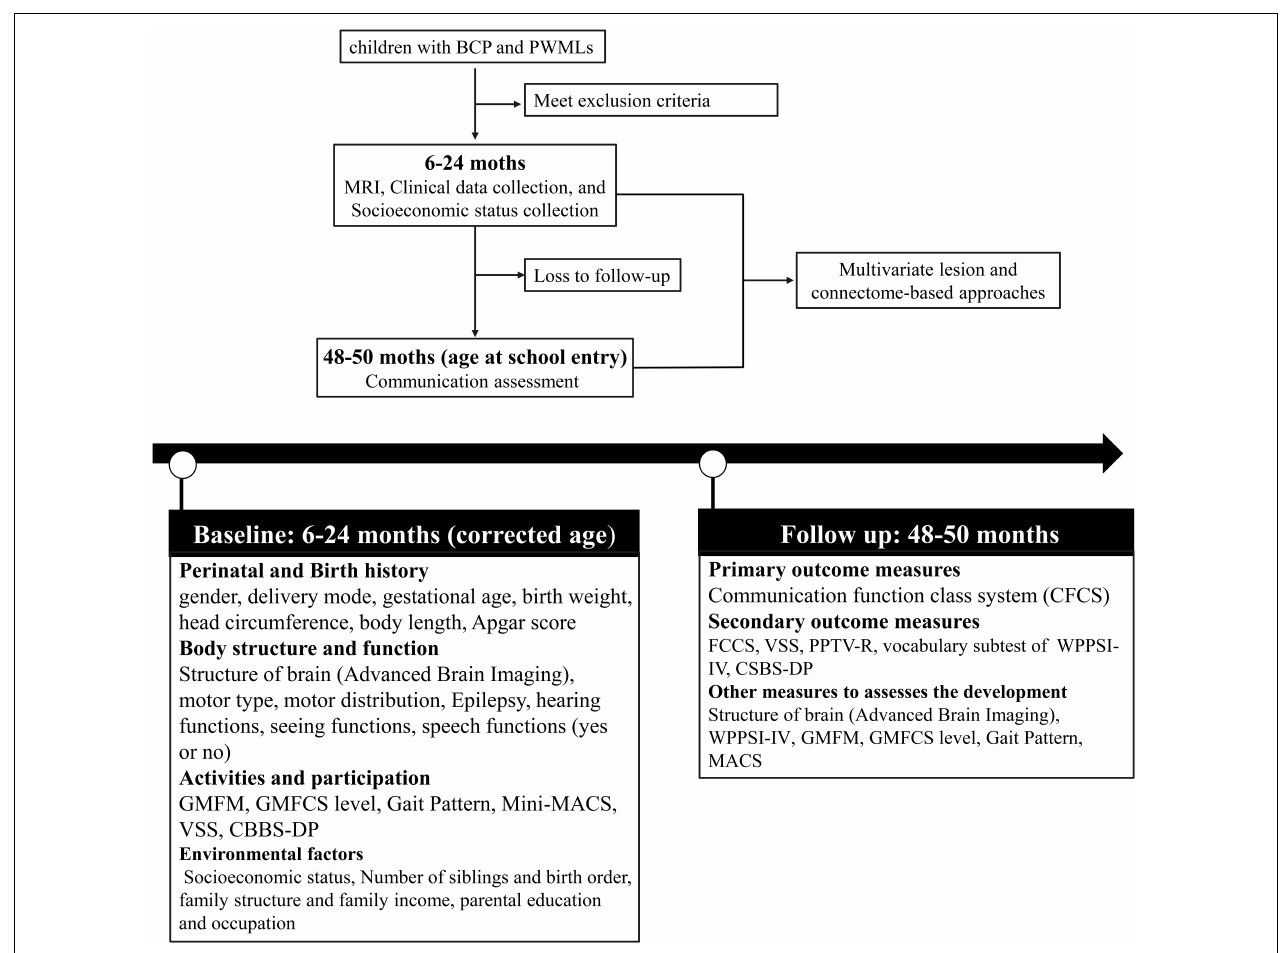
FIGURE 1 | Flow chart of the study protocol. BCP, Bilateral Cerebral Palsy; PWML, Periventricular White Matter Lesion; MRI, Magnetic Resonance Imaging; GMFM, Gross Motor Function Measure; GMFCS, Gross Motor Function Classification System; MACS, Manual Ability Classification System; VSS, Viking Speech Scale; CBBS-DP, Communication and Symbolic Behavior Scales Developmental Profile; FCCS, Function Communication Classification System; PPTV-R, Peabody Picture Vocabulary Test-Revised; WPPSI-IV, Wechsler Preschool and Primary Scale of